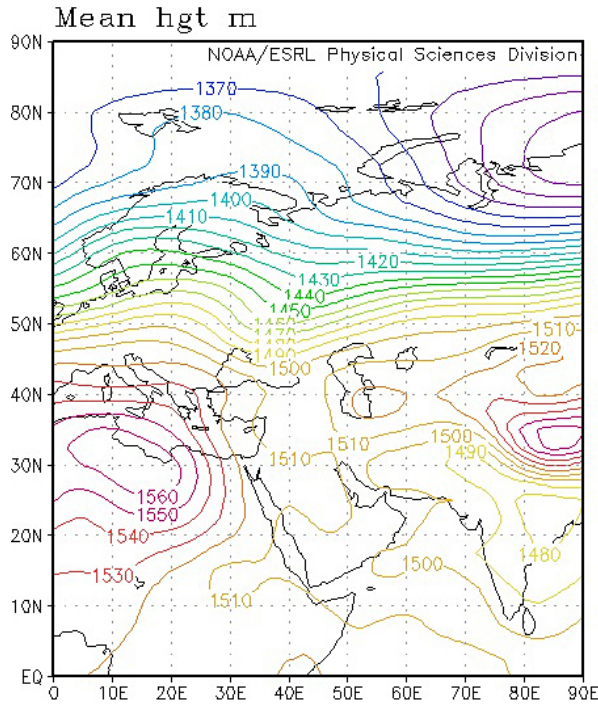
Figure 2. Map of the 850hPa geopotential heights averaged for the period 1 September–31 October 2013 from the NOAA- NCEP/NCAR (National Oceanic and Atmospheric Administration– National Centers for Environmental Prediction/National Center for Atmospheric Research) reanalysis database.